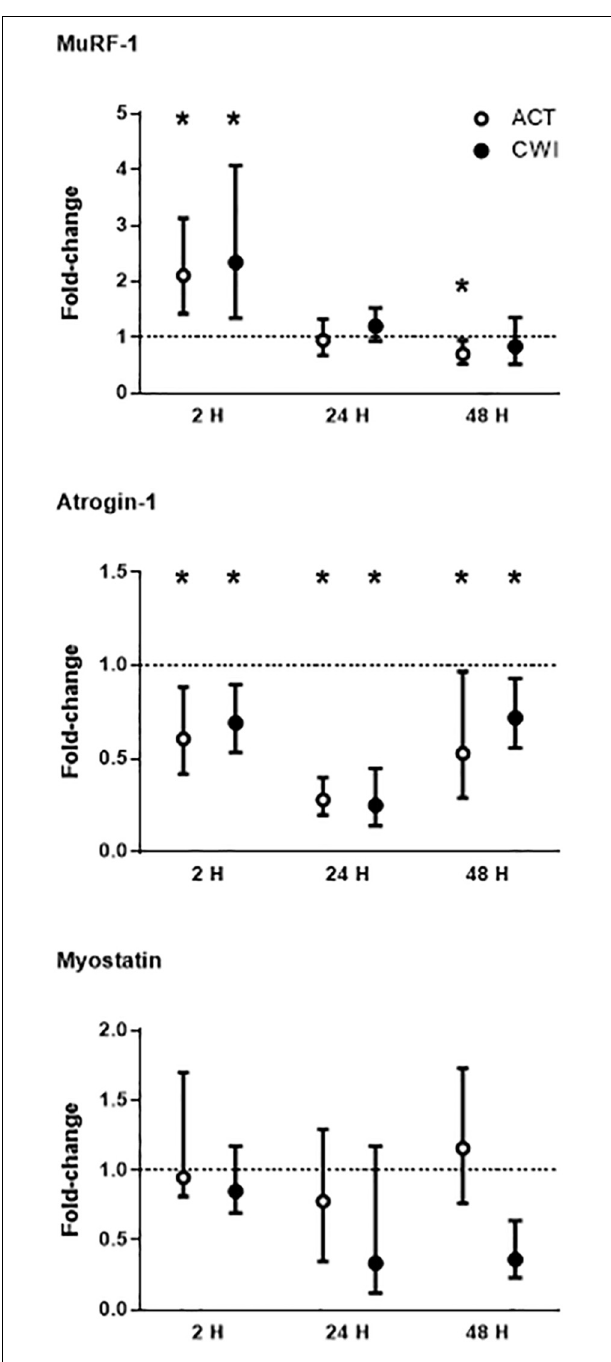
FIGURE 3 | Post-exercise changes in mRNA expression of muscle-specific RING finger 1 (MuRF-1), atrogin-1 and myostatin. Data are presented as the median ± interquartile range. * P < 0.05 versus pre-exercise. ACT, active recovery; CWI, cold water immersion. The dotted line represents a nominal pre-exercise value of 1.0 (for